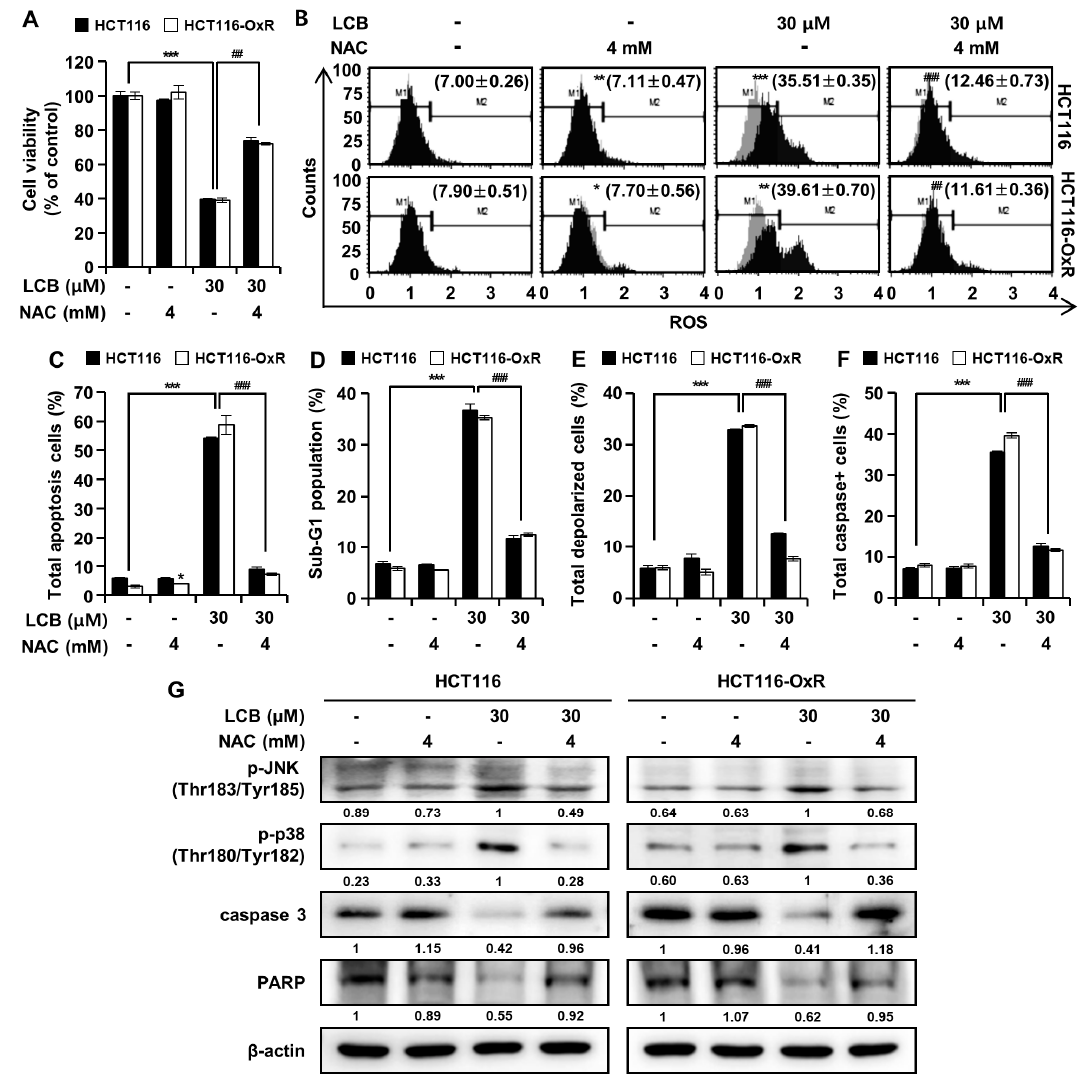
Figure 6. LCB-induced apoptosis is associated with ROS generation in CRC cells. HCT116 and HCT116-OxR cells were pretreated with 4 mM NAC for 3 h and then treated with 30 μ M LCB for 48 h. ( A ) Cell viability of HCT116 and HCT116-OxR cells as determined using the MTT assay. Flow cytometry assay analysis of ROS ( B ), apoptosis ( C ), cell cycle ( D ), MMP ( E ), and multi-caspase ( F ) in CRC cells. ( G ) Protein expression of p-JNK, p-p38, caspase 3, and PARP in CRC cells, as determined by Western blot assay. All data are represented as the mean ± SD ( n = 3), * p < 0.05, ** p < 0.01, *** p < 0.001 compared with the control group (0 μ M); ## p < 0.01, ### p < 0.001 compared with the LCB-treated group (30 μ M).